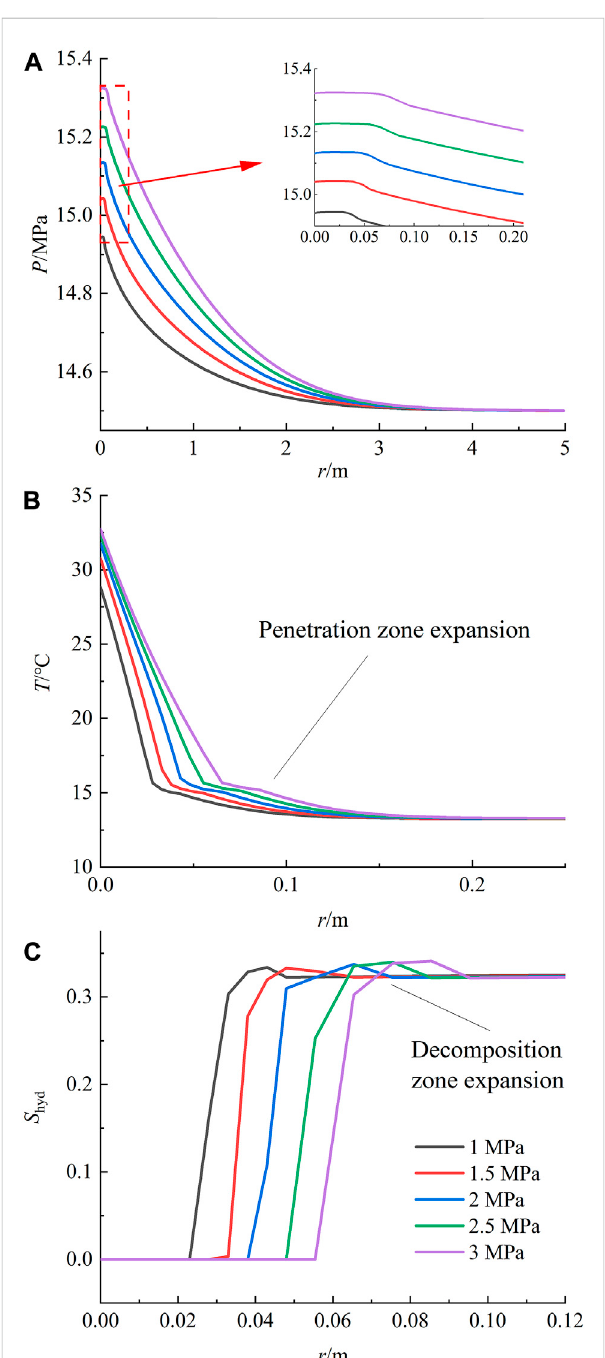
FIGURE 8 Changes in the main physical properties of the sediment around the wellbore at 25 min under different exothermic rates. (A) Pressure. (B) Temperature. (C) Hydrate saturation.